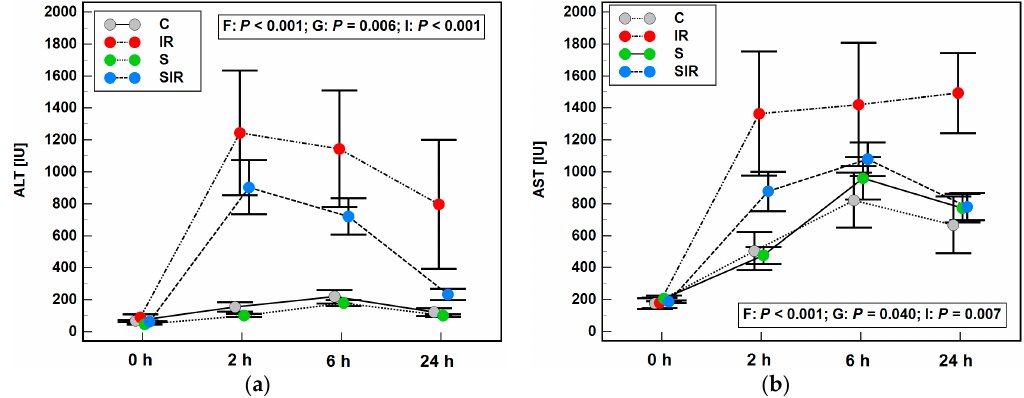
Figure 1. Validation of hepatic ischemia-reperfusion model—the effect of injury on the dynamics of liver enzymes: ( a ) alanine aminotransferase (ALT); ( b ) aspartate aminotransferase. Data are presented as mean ± SEM and were analyzed using repeated-measures ANOVA. F, the effect of factor (time of blood sampling after IR); G, the effect of group (C, IR, S, SIR); I, the effect of factor × group interaction; C, control sham-operated animals; IR, animals subjected to ischemia-reperfusion; S, sham-operated animals pretreated with sitagliptin; SIR, animals subjected to ischemia-reperfusion pretreated with sitagliptin.